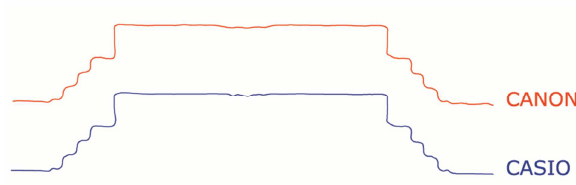
Figure 6. Comparison of the horizontal section obtained with two different cameras: a) model1, Canon EOS 350D; b) model2, Casio EX-H15